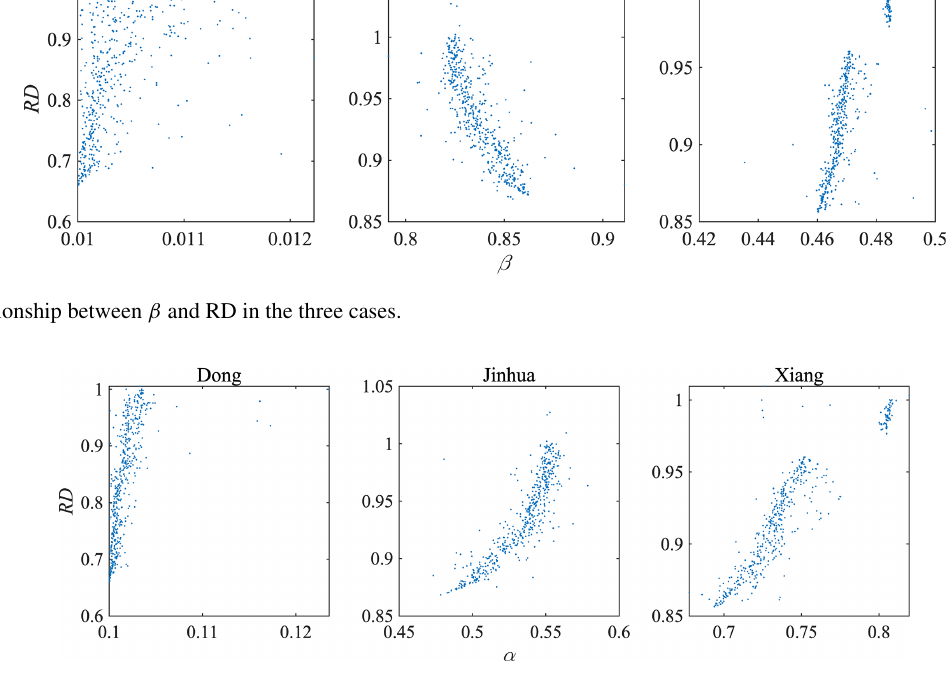
creases with increasing catchment areas. This agrees with the regular pattern that the generation time of slow flow is highly related to the area of the